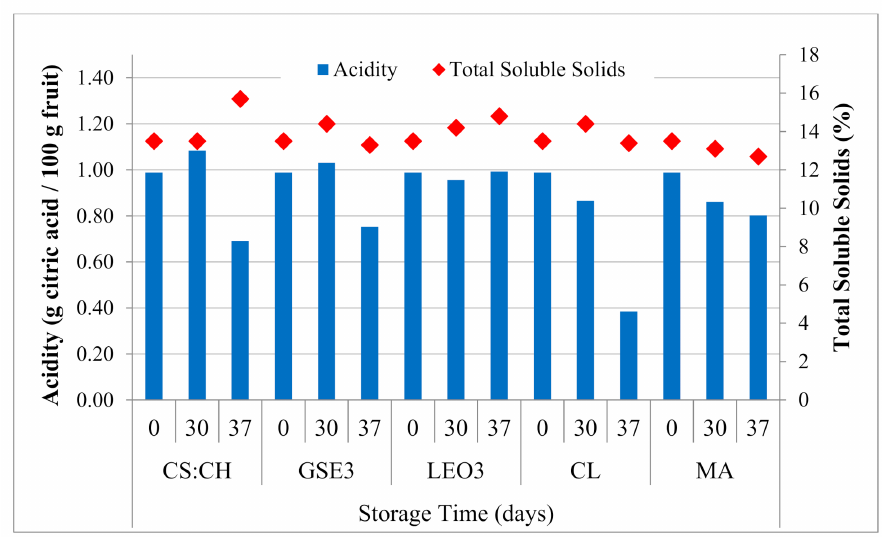
Figure 4. Evolution of titratable acidity and total soluble solids of blueberries Emerald var. during refrigerated storage. Fruit were packed in clamshell (CL), biodegradable films based on corn starch and chitosan (CS:CH), active biodegradable films containing 3% grapefruit seed extract (GSE3) or 3% lemon essential oil (LEO3), and modified atmosphere commercial bags